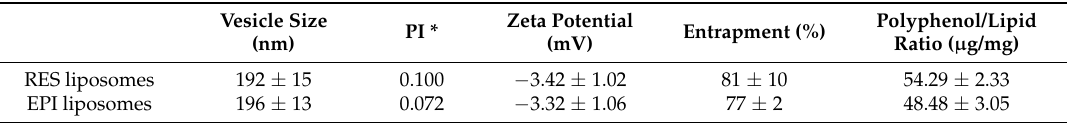
Table 1. Liposomal size, size distribution, zeta potential, and entrapment efficiency of RES- or EPI- containing